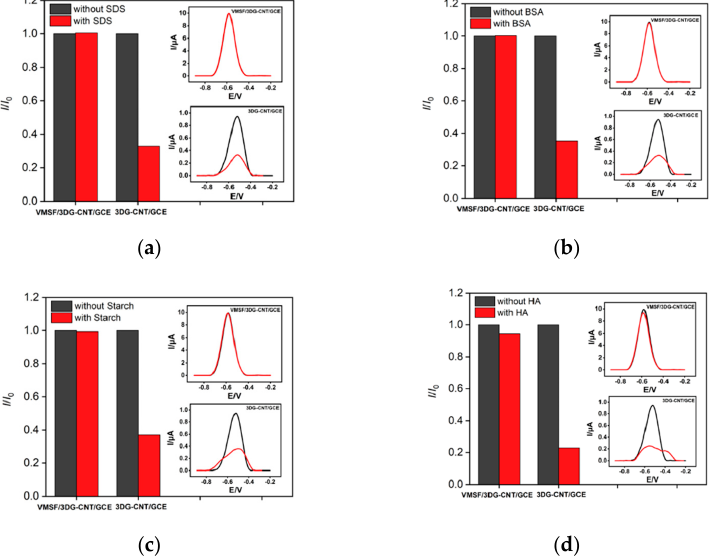
Figure 6. Normalized oxidation peak current ratio of the VMSF/3DG-CNT/GCE and 3DG-CNT/GCE towards PQ (1 μ M). I and I 0 represent the currents obtained in the present and absence of 20 μ g/mL of SDS ( a ), BSA ( b ), starch ( c ) or HA ( d ) in 0.1 M PBS (pH = 6). The insets are the corresponding DPV curves obtained for the 3DG-CNT/GCE and VMSF/3DG-CNT/GCE in the absence and presence of the fouling species.